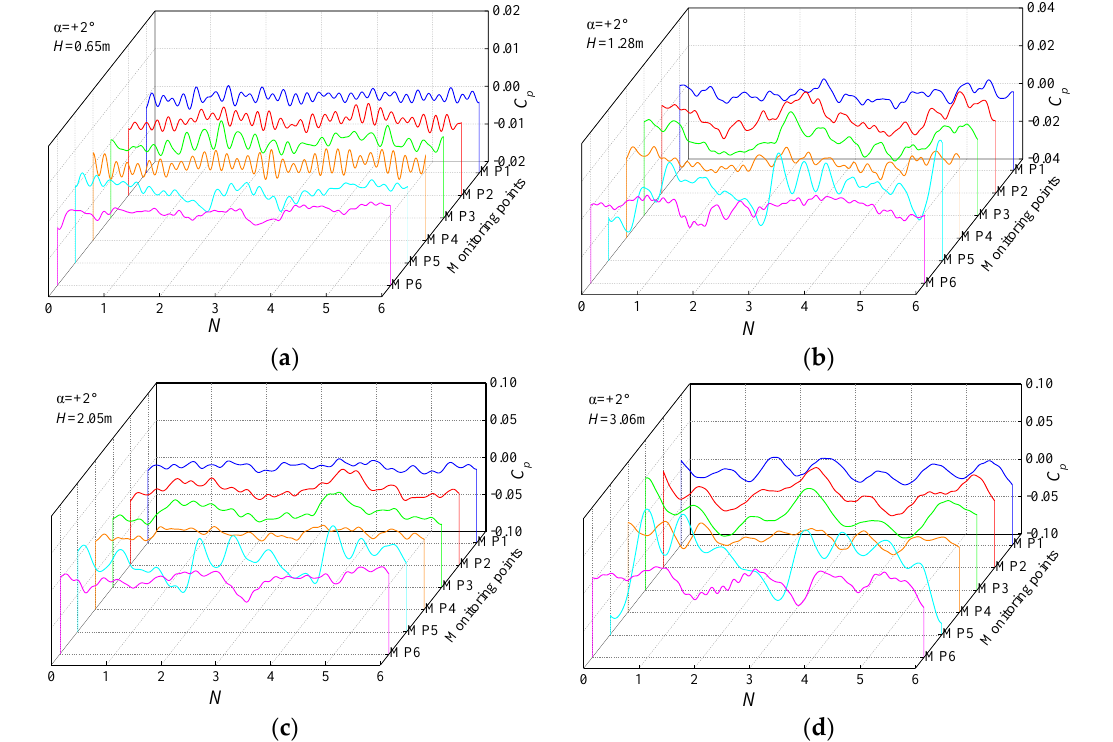
Figure 4. Comparison of time domain pressure pulsation coefficient of different MPs at α = +2° with different runaway heads. ( a ) shows the pulsation coefficient curves at H = 0.65 m. ( b ) shows the pul-sation coefficient curves at H = 1.28 m. ( c ) shows the pulsation coefficient curves at H = 2.05 m. ( d ) shows the pulsation coefficient curves at H = 3.06 m.